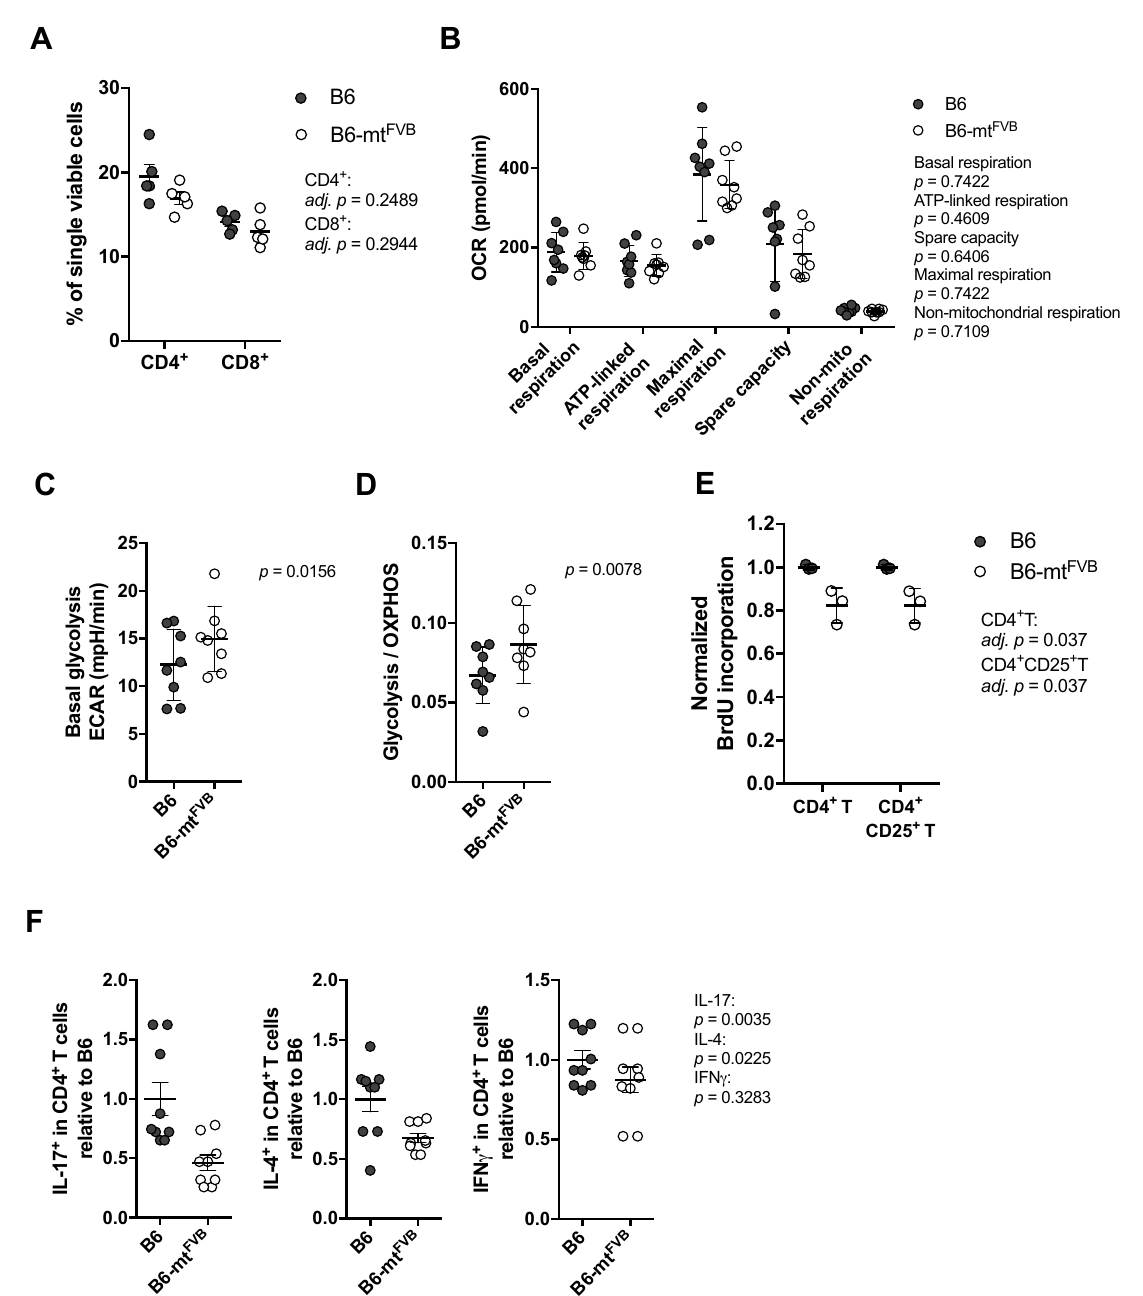
Figure 2. The natural variation m.7778G > T in the mt-Atp8 gene alters the respiratory profile in CD4 + T cells. ( A ) The proportion of CD4 + T cells and CD8 + T cells in the spleen from B6-mt FVB was comparable to that from B6 mice. CD4 + T cells, adj. p = 0.2489; CD8 + T cells, adj. p = 0.2944; multiple t test. N = 5 (2 males and 3 females)/strain, 2 to 3 months old. ( B ) Oxygen consumption rate (OCR) in CD4 + T cells from B6-mt FVB and B6 mice were determined using the Seahorse XF